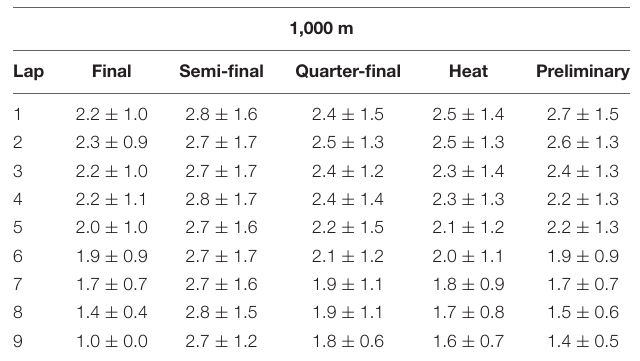
TABLE 3 | Mean value and standard deviation of lap rankings for 1,000 m champions.